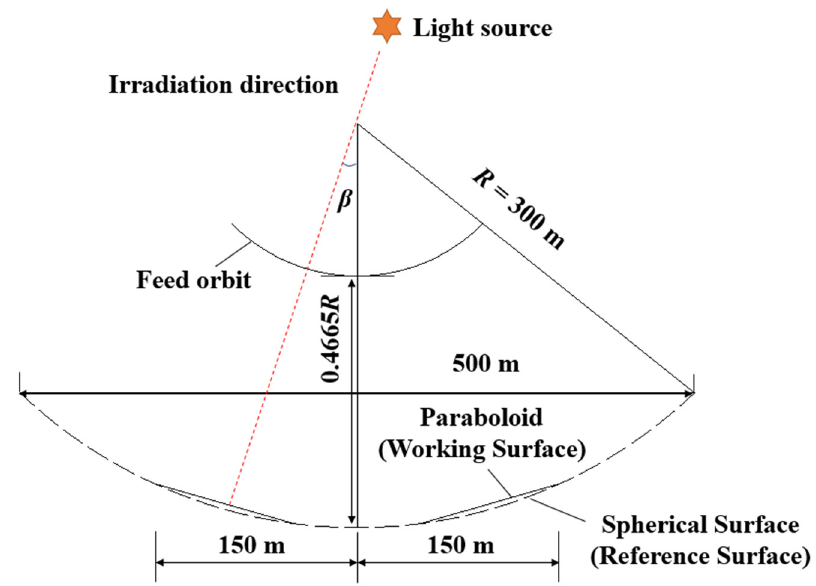
Figure 2. Relationship between the reference state and working state.